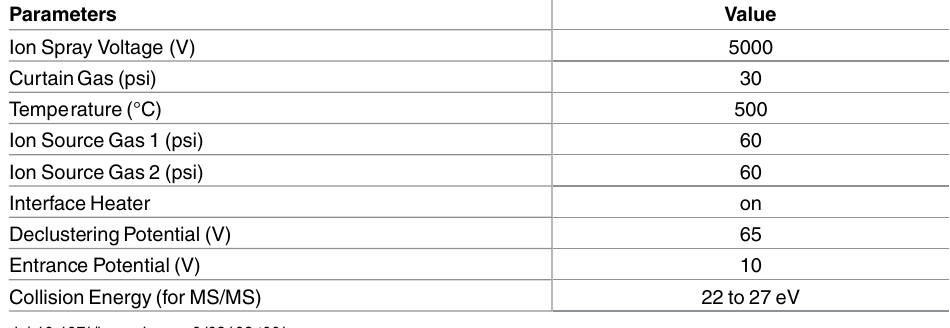
Table 1. Mass Spectrometer SettingsUsed for Metabolite Profilingof FTY720-C2 and FTY720-Mitoxy.